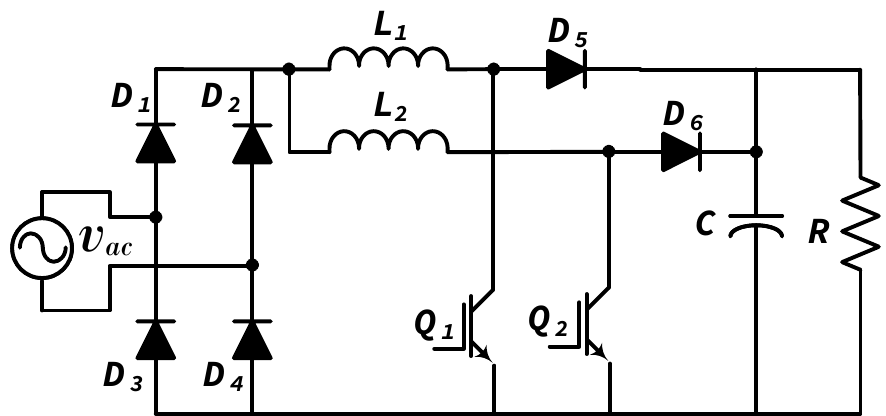
Figure 3. Interleaved PFC